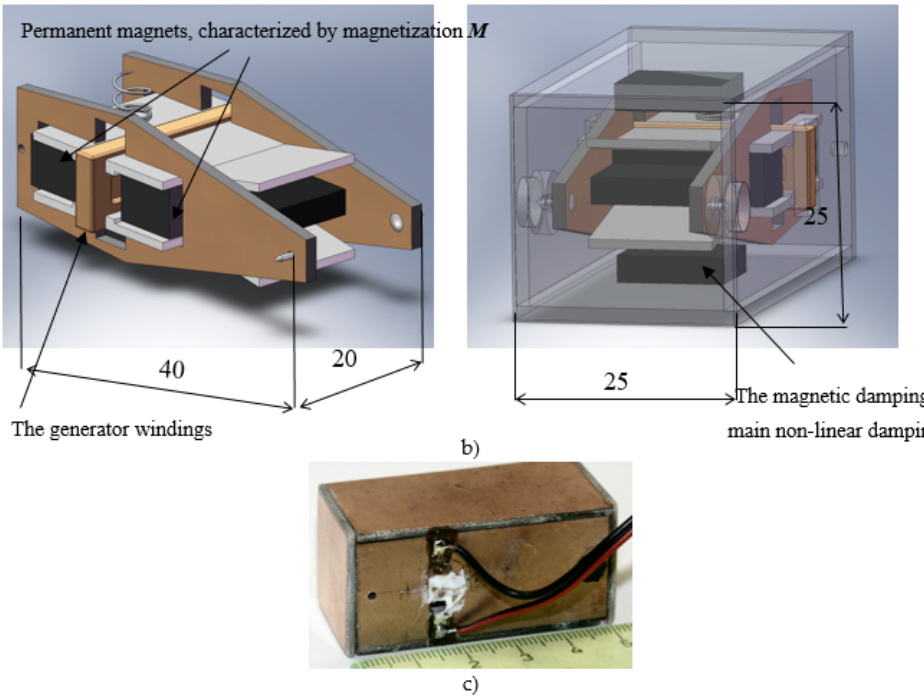
Figure 2. The geometrical model of microgenerator (MG), ( a ) a primary version (magnetic bearing), ( b ) dimensions in mm for MG of BV, ( c ) experimental BV generator.